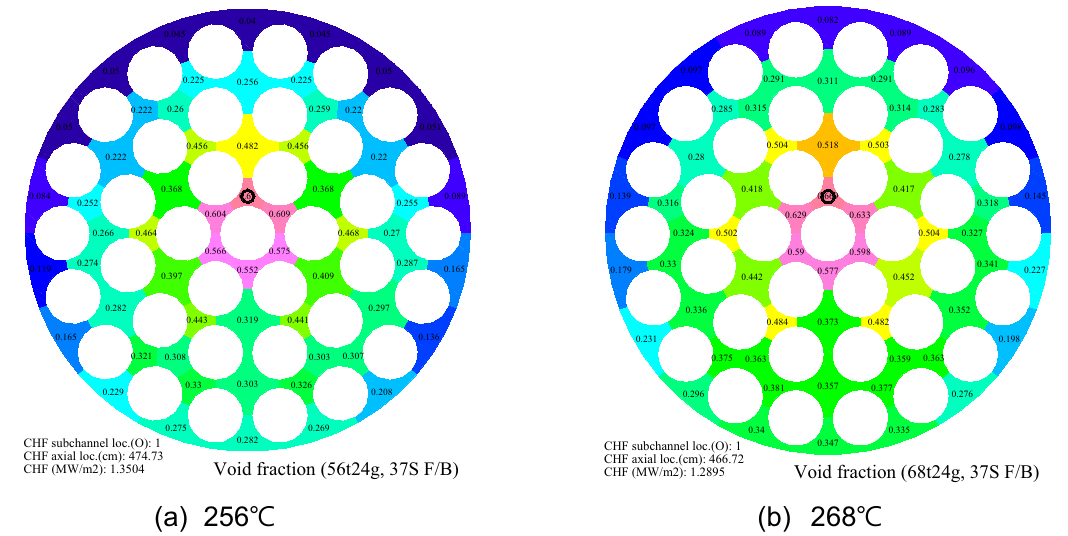
Fig. 6. Void fraction of a 37S fuel bundle for the uncrept pressure tube at 24